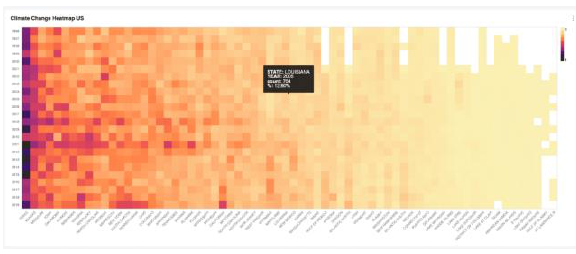
Figure 5. Pixel Display Examples (URL-2) -